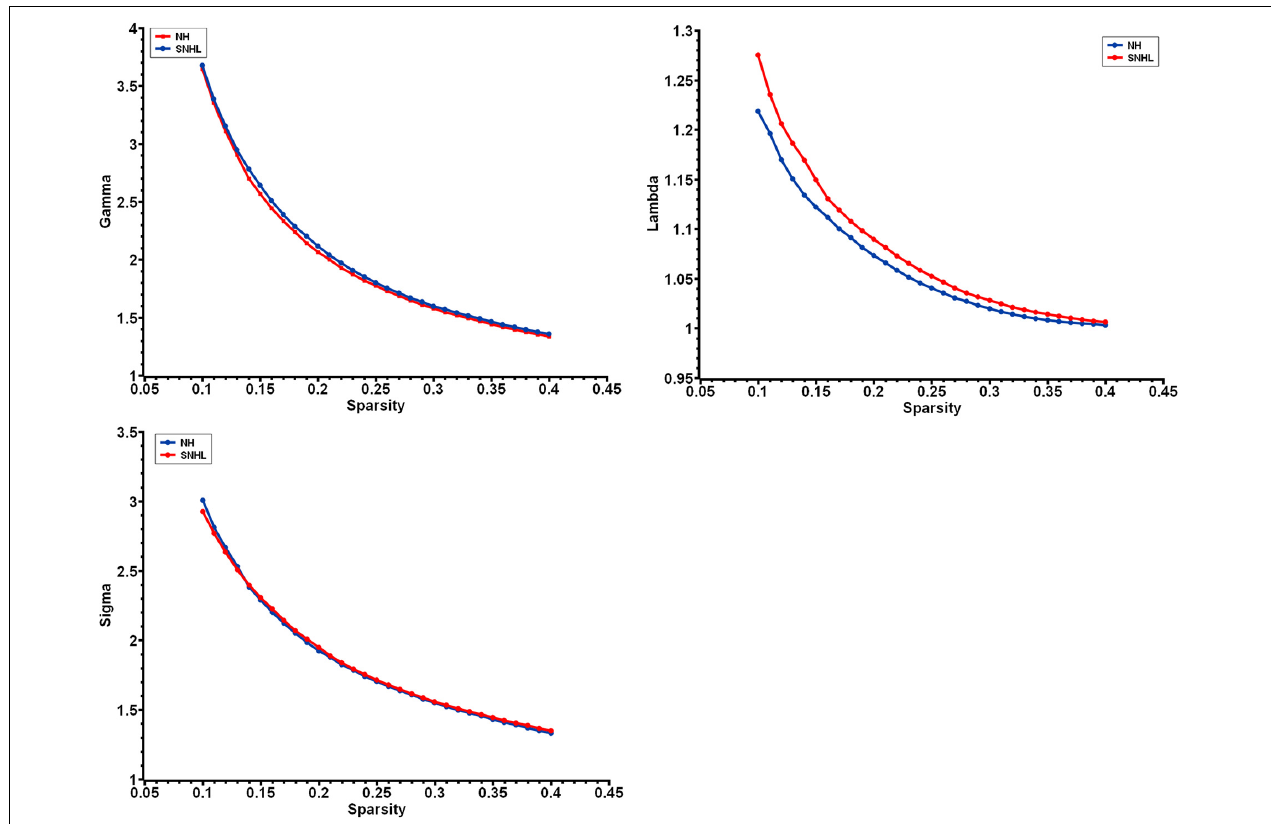
FIGURE 2 | The small-world parameters of functional networks as a function of sparsity threshold from 0.1 to 0.4. Both the NH group and SNHL group exhibited γ , λ , and σ larger than 1, which indicates that both groups exhibited the small-word organization. (NH, normal hearing; SNHL, sensorineural hearing loss; γ , normalized clustering coefficient; λ , normalized characteristic path length; σ , small-worldness).